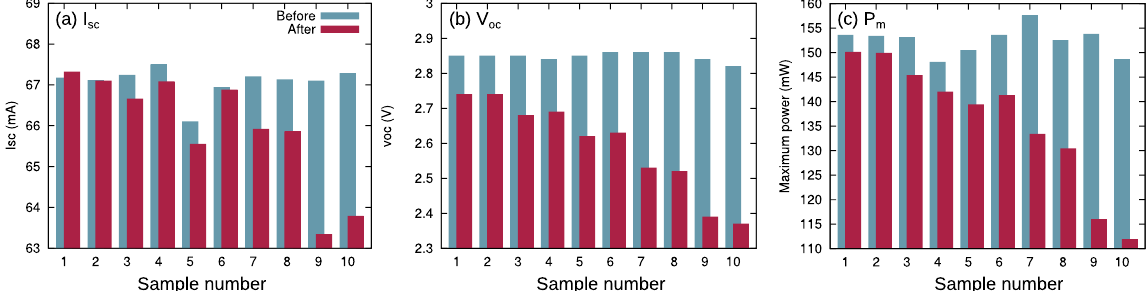
Figure 2. Summary of I–V measurements. The data shown are for ( a ) short circuit current, ( b ) open circuit voltage, and ( c ) maximum power before (blue bars) and after (red bars) electron